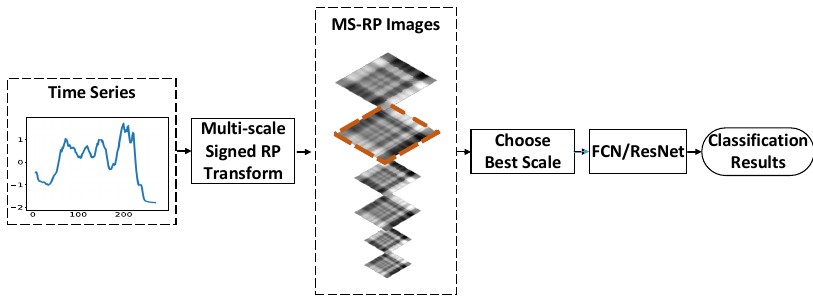
Figure 1. The framework of our approach. The x -axis and y -axis of time series represent the length and the amplitude,